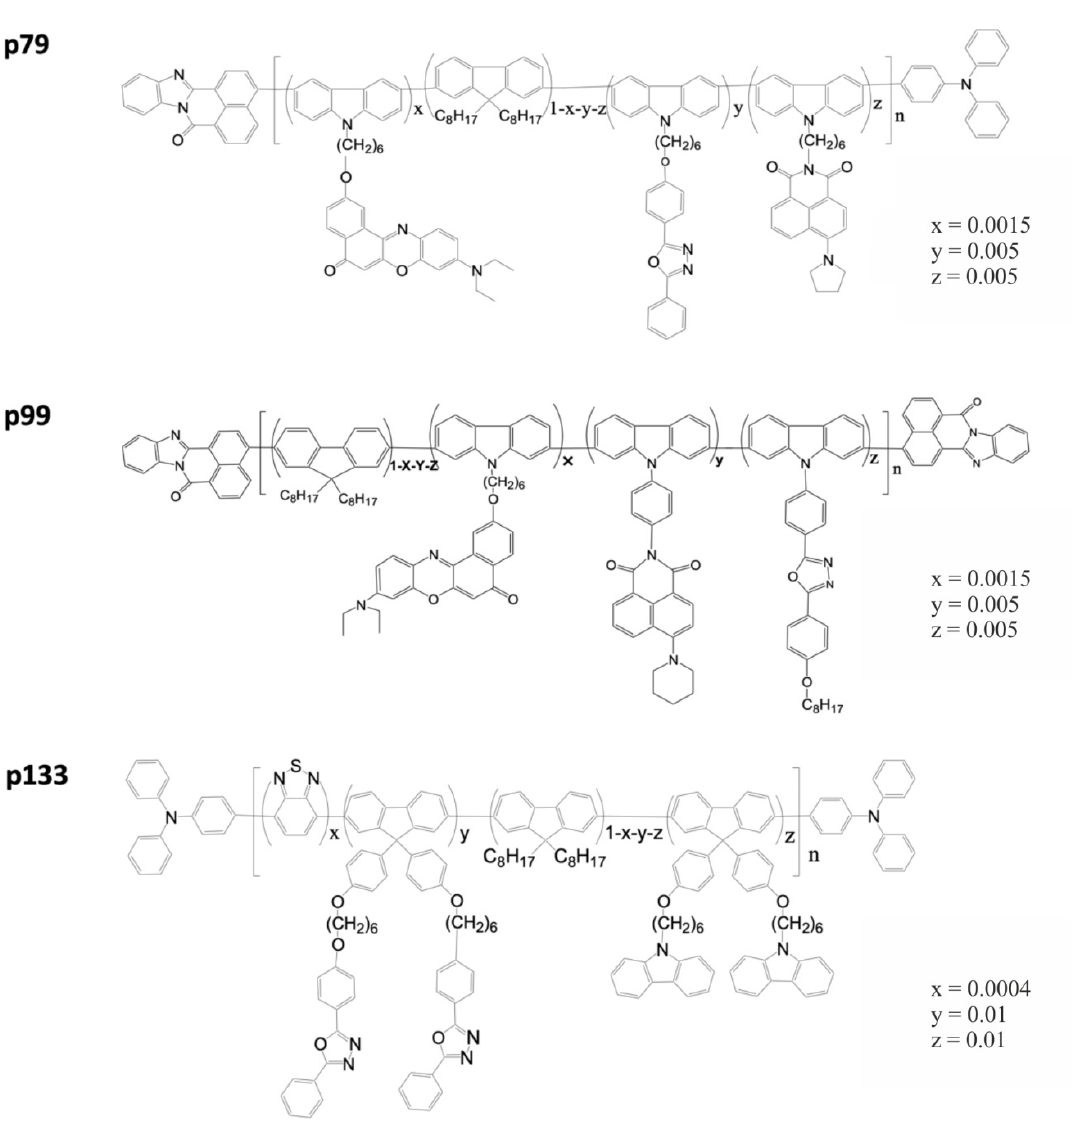
Figure 2. Structural formulas of the p79, p99, and p133 polyfluorene-based polymers.